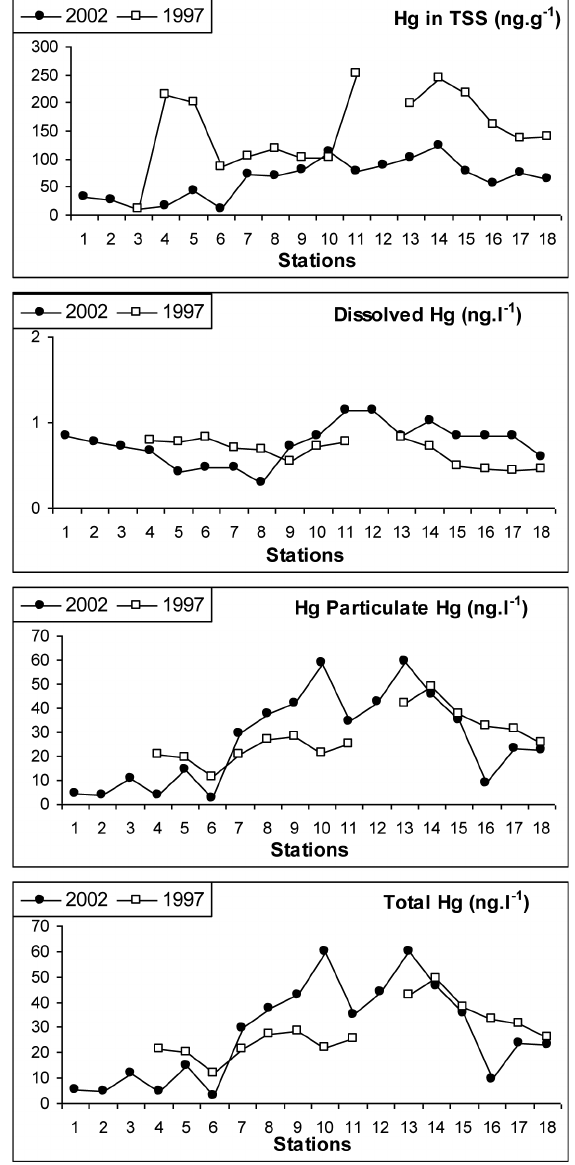
Figure 3. Mercury distribution in suspended matter and waters in the Madeira River from Porto Velho (stations 15 to 18), the middle section (14 to 5) to the confluence with the Amazon River (stations 4 to